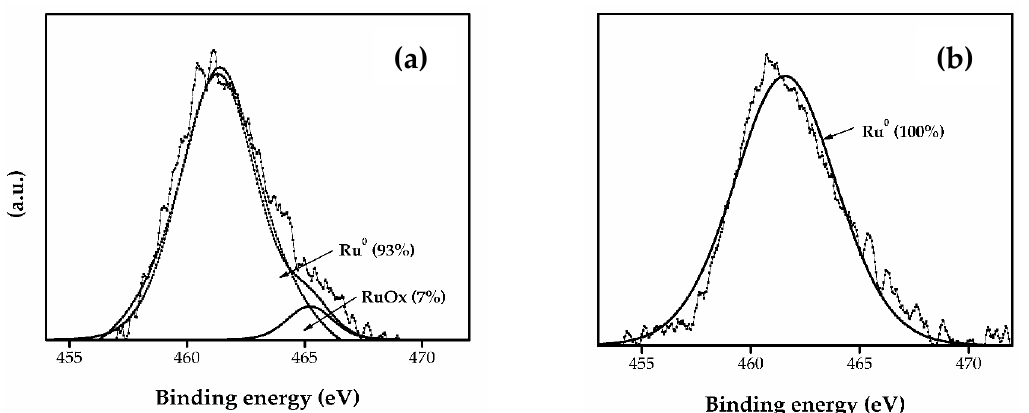
Figure 4. Ru3p 3/2 XPS signals for Ru/Al 2 O 3 -Ca(10 wt%) ( a ) and Ru/Al 2 O 3 -K(10 wt%) ( b ) catalysts.